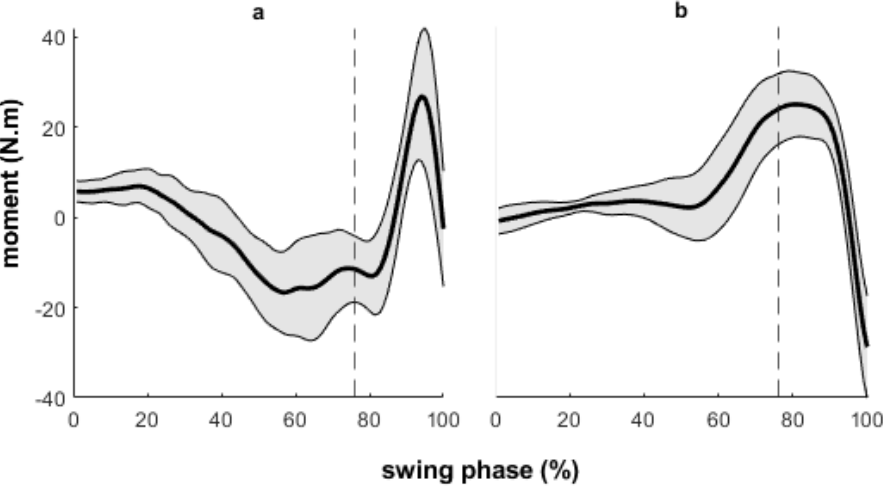
Figure 3. Normalised time histories for elbow resultant moments: ( a ) elbow flexion [+]/extension [ − ] and ( b ) elbow pronation [+]/supination [ − ]. Vertical dashed line indicates the mean end of back swing instant (Figure 1).